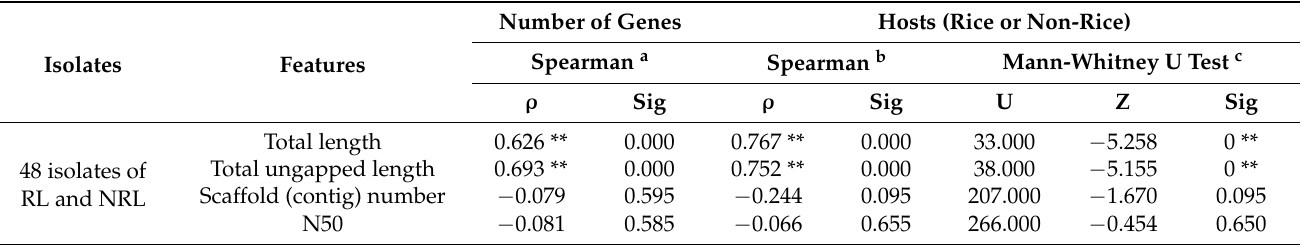
Table 2. Correlation analyses between four genomic features and the number of shared genes in each isolate and